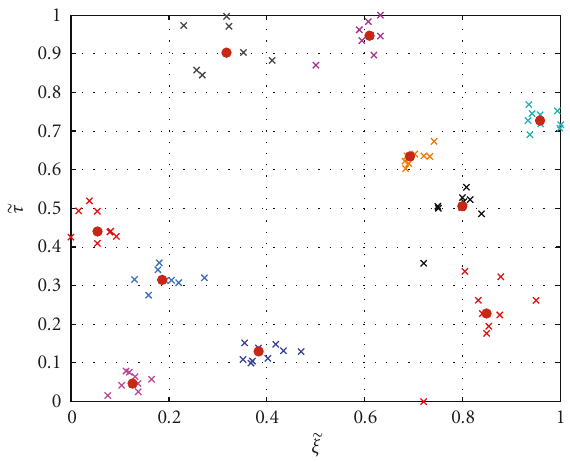
Figure 4: Clusters on the (cid:30) τ versus (cid:30) ξ plane in a 10-user scenario (30 dB SNR is assumed for all user signals over MP channel).